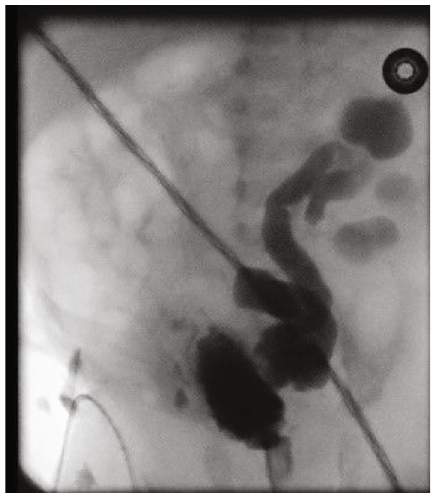
Figure 3: Dilated posterior urethra and left grade V re fl ux.